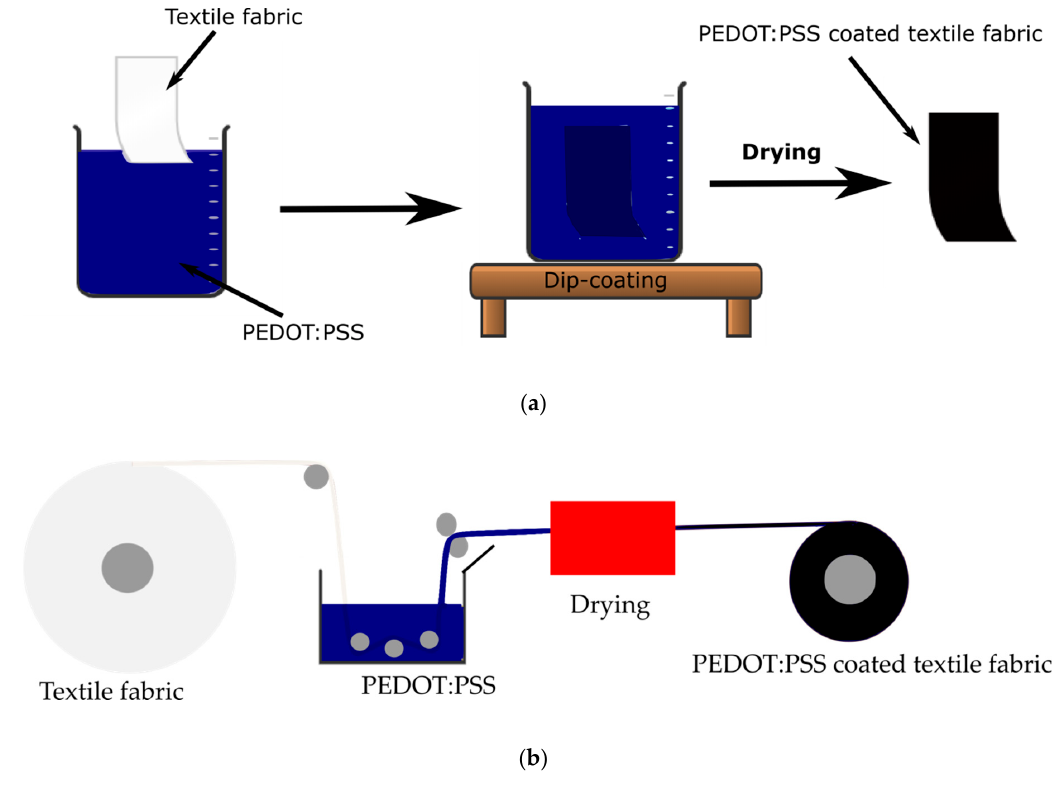
Figure 5. Schematic representation of the setup for dyeing: ( a ) discontinuous process; ( b ) continuous process.